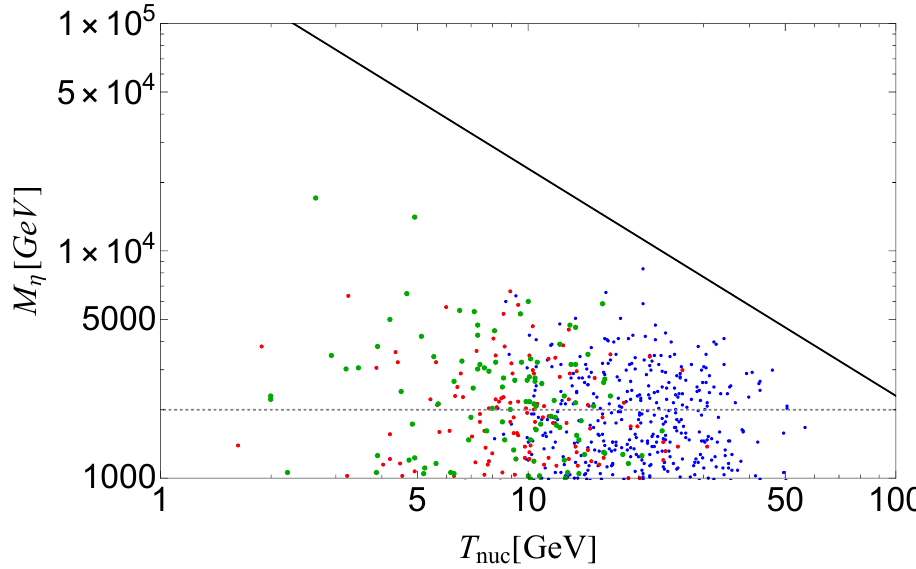
Figure 5 . M η (which is the lightest colored particle mass) vs T nuc in the low energy baryogenesis. The green points satisfy (3.43), while the red and blue points do not satisfy it and thus require a special flavor-structure. Both (the lighter of) M and M are taken to satisfy the conditions from 1 2 maximal wall velocity (A.8), which is shown by the black solid line, in the appendix for green and red (blue) points. Here we fix h H i = T = 100 GeV to consider the electroweak phase transition reh and fix ∆ n = 8 . 8 × 10 − 11 . Other parameters are randomly chosen within the perturbative B /s unitarity range. Below the 2TeV (dotted line) may be disfavored by the null detection of new colored particle in the